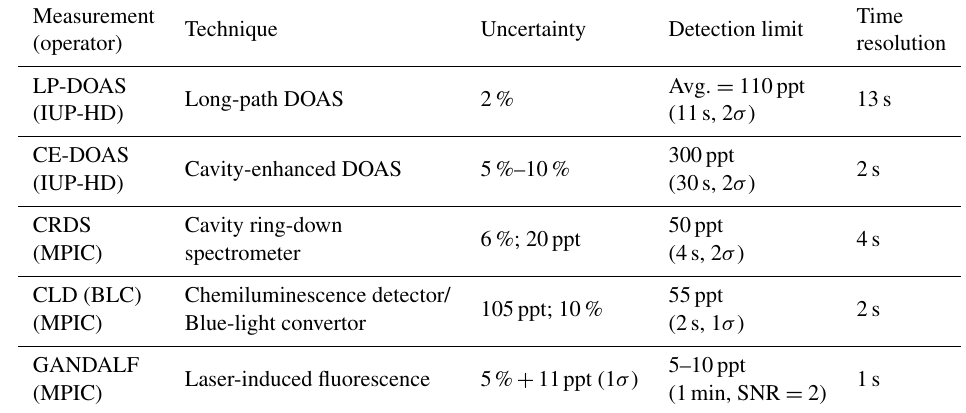
Table 2. NO 2 instruments located or sampling at the top of the platform during PARADE 2011.